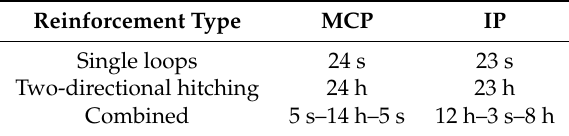
Table 3. Tested reinforcement layouts on the MCP (l = 35 mm) and IP (l = 32.5 mm)